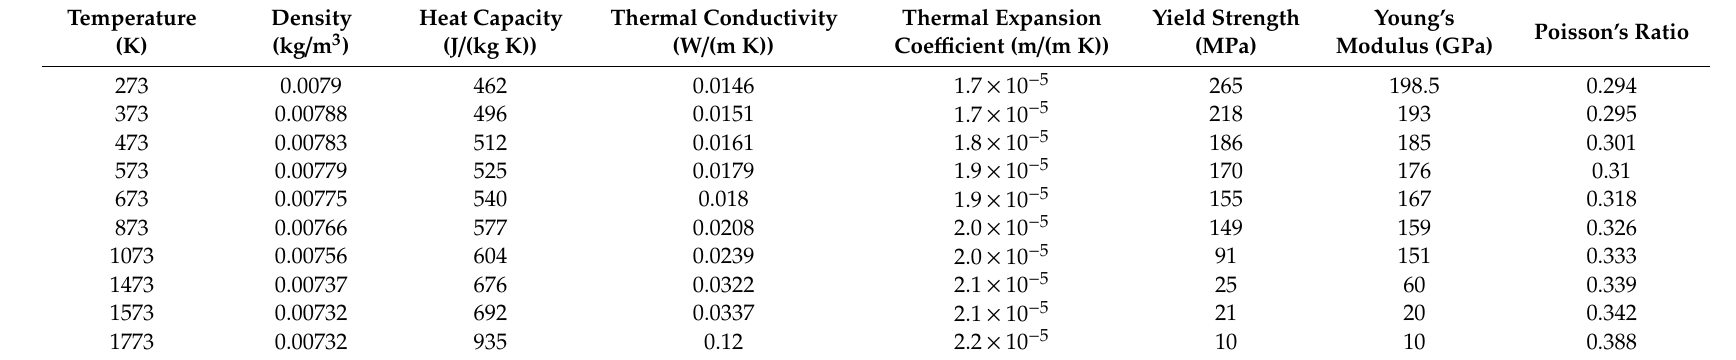
Table 1. Material properties for the 304 stainless steel base plate [26].